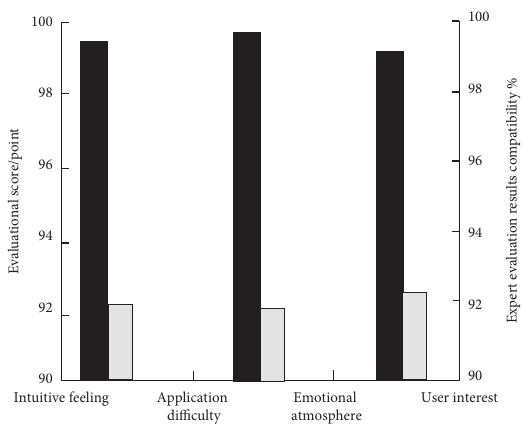
Figure 8: Comparison results of the teaching effects of the three